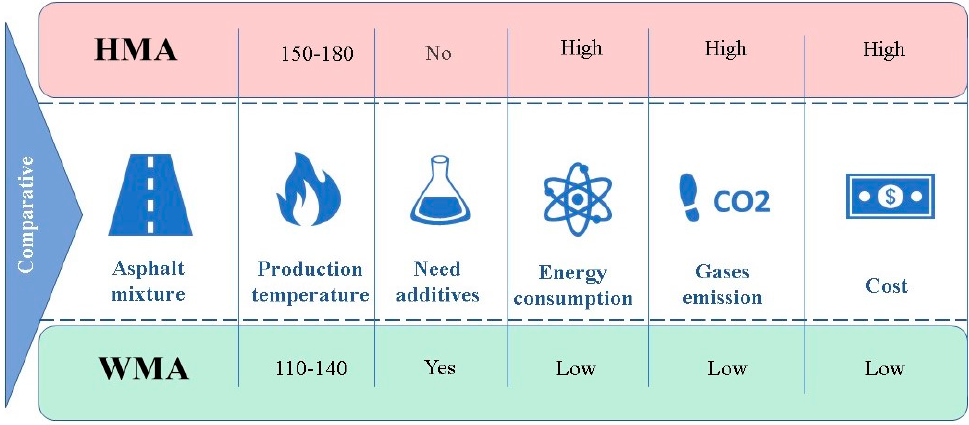
Figure 2. Comparison of HMA and WMA.